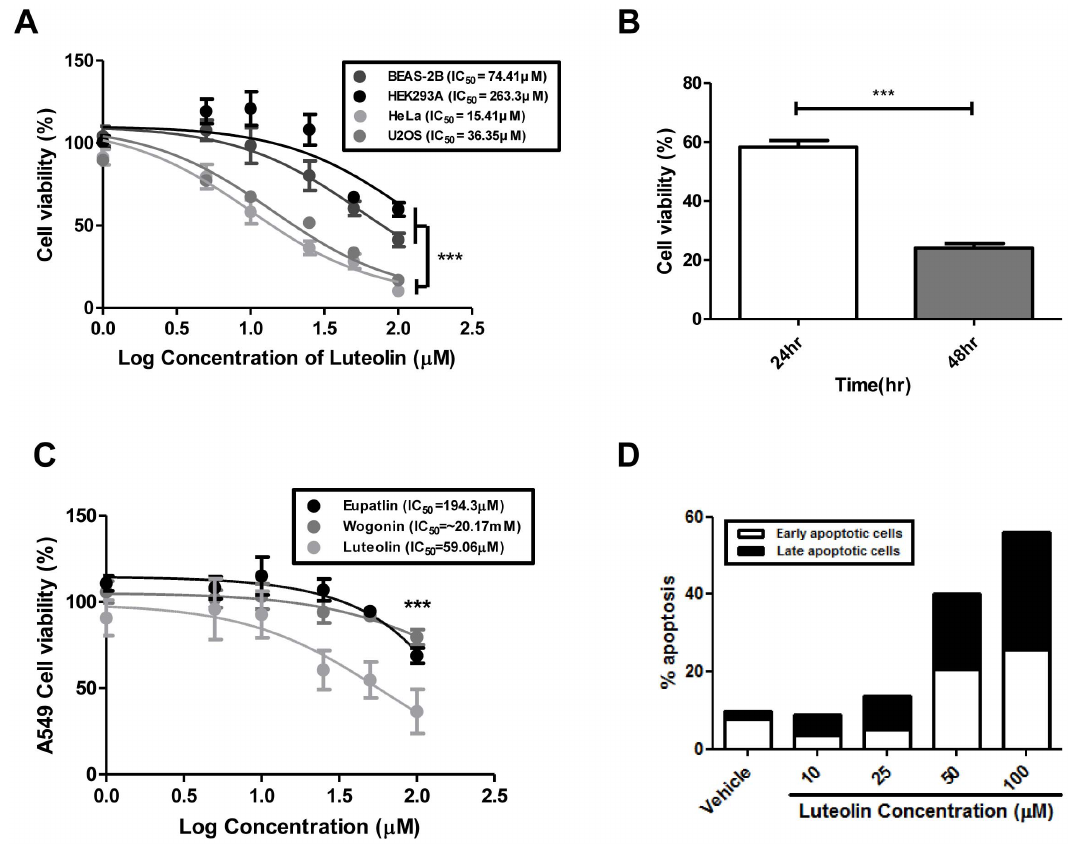
Figure 5. Luteolin exhibits selective cytotoxicity towards tumorigenic cells and induces apoptosis. (A), The effects of luteolin on cell viability of tumorigenic (HeLa and U2OS) and non-tumorigenic (BEAS-2B and HEK293A) cell lines. Cells were treated with indicated concentration of luteolin for 24 hours. Afterward, cell viability was analyzed by the MTT assay. (B), Time-dependent effects of luteolin on HeLa cell viability. HeLa cells were treated with indicated luteolin 10 m M for indicated times. Cell viability was assessed by the MTT assay. Error bars represents means 6 SEM (n=10). Symbols (***) represent p value , 0.0001. (C), The effects of flavonoids on A549 cell viability were compared. Error bars represent means 6 SEM (n=10). Symbols (***) represent p value , 0.0001. The P-values in (A), (B) and (C) were calculated using Student’s t-test. (D), Proapoptotic effect of luteolin on HeLa cells. HeLa cells treated with indicated concentrations of luteolin were double stained with PI/Annexin-V allophycocyanin. Apoptosis analysis was performed by flow